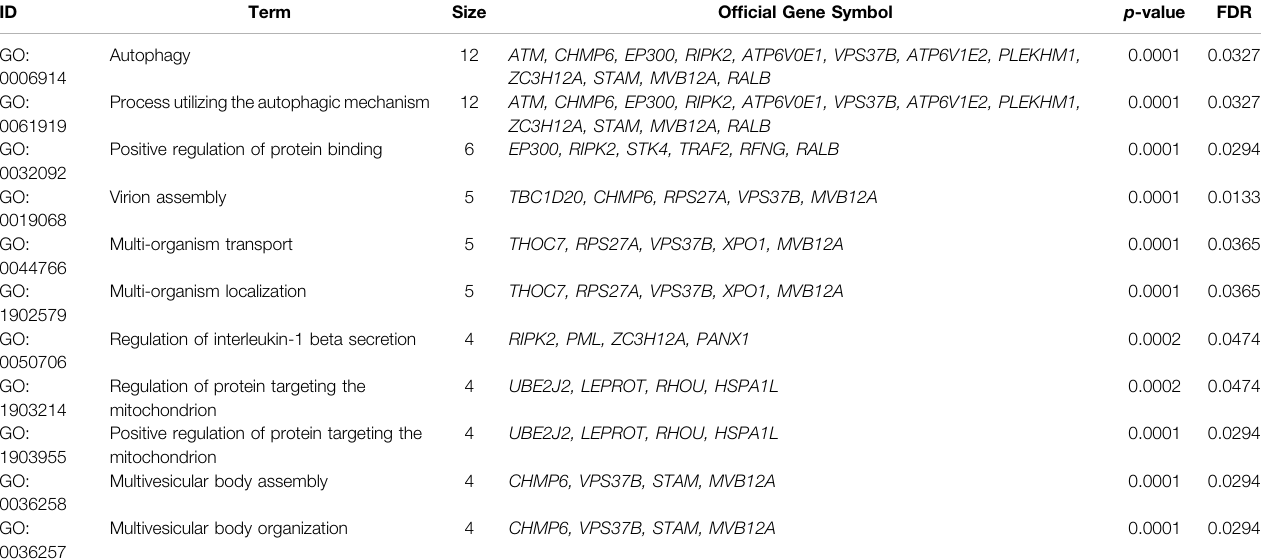
TABLE 1 | Gene Ontology biological process enrichment analysis of 144 speci fi c DEGs in severe COVID-19 cases.